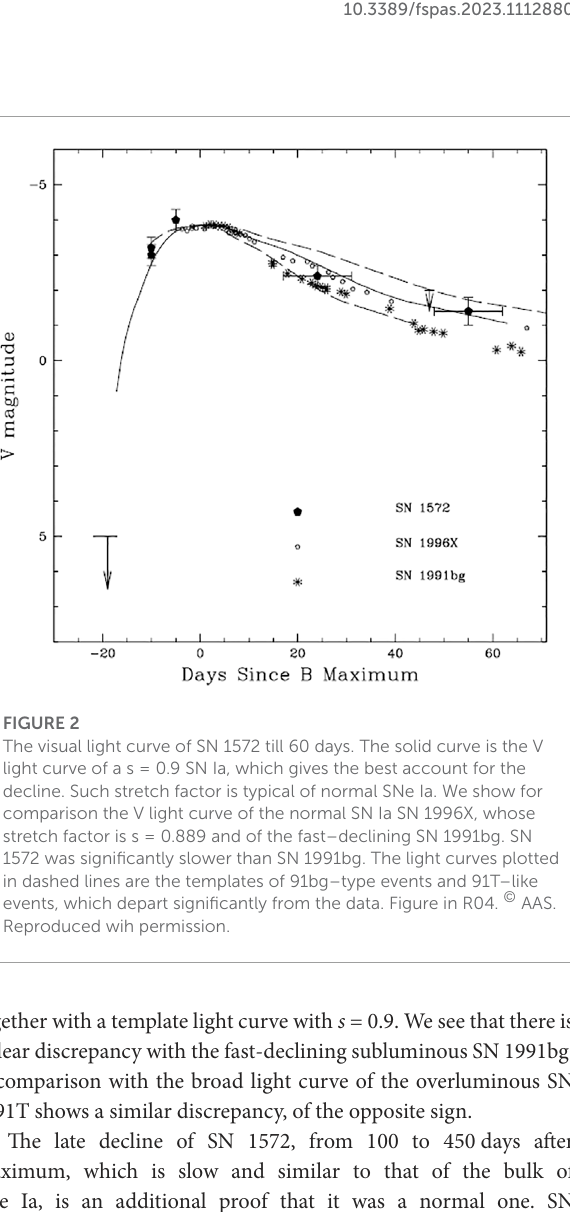
together with a template light curve with s = 0.9. We see that there